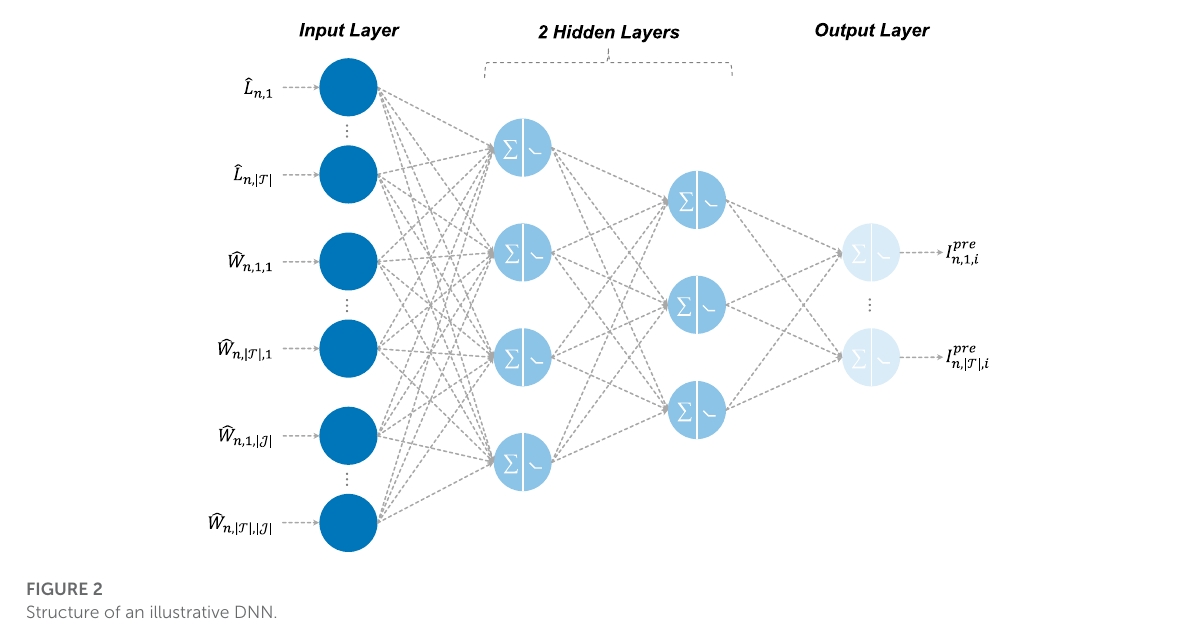
FIGURE 2 Structure of an illustrative